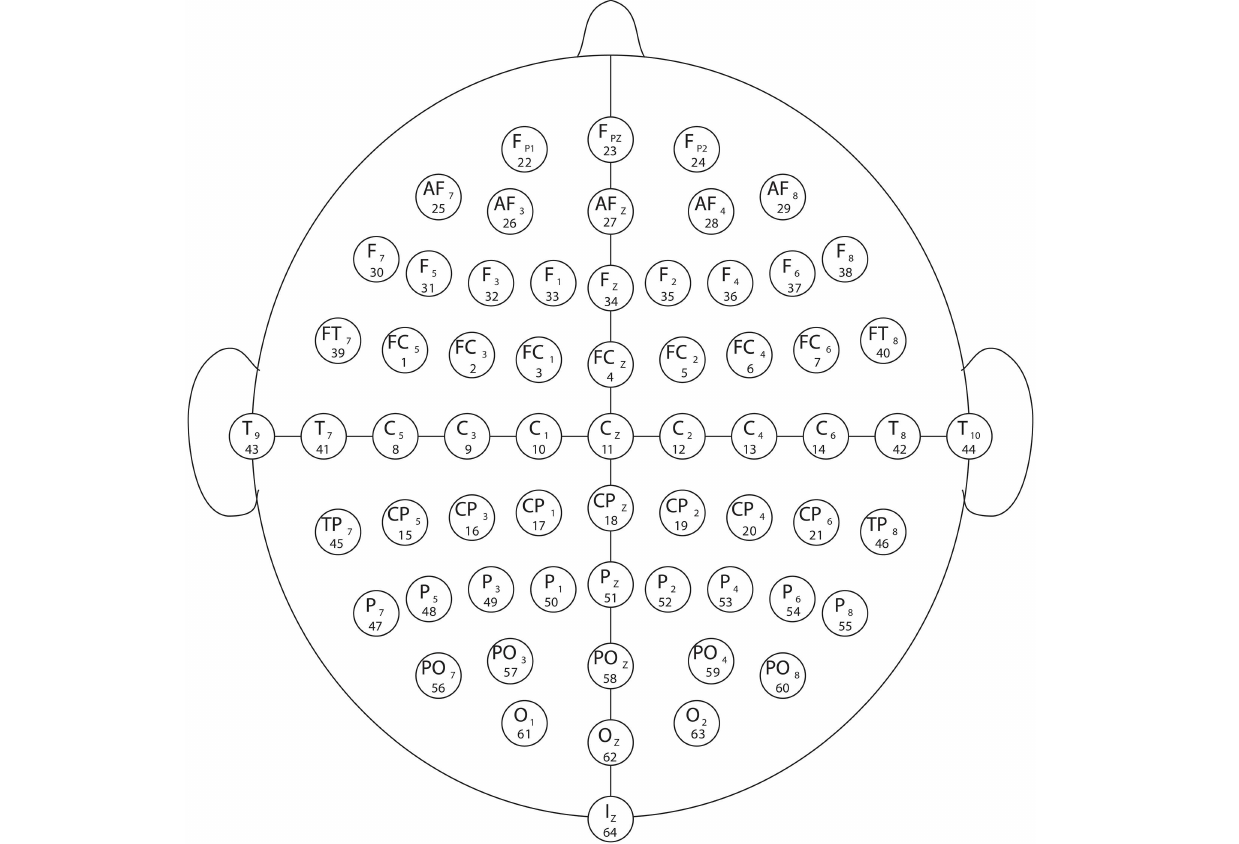
Frontiers in Physics |